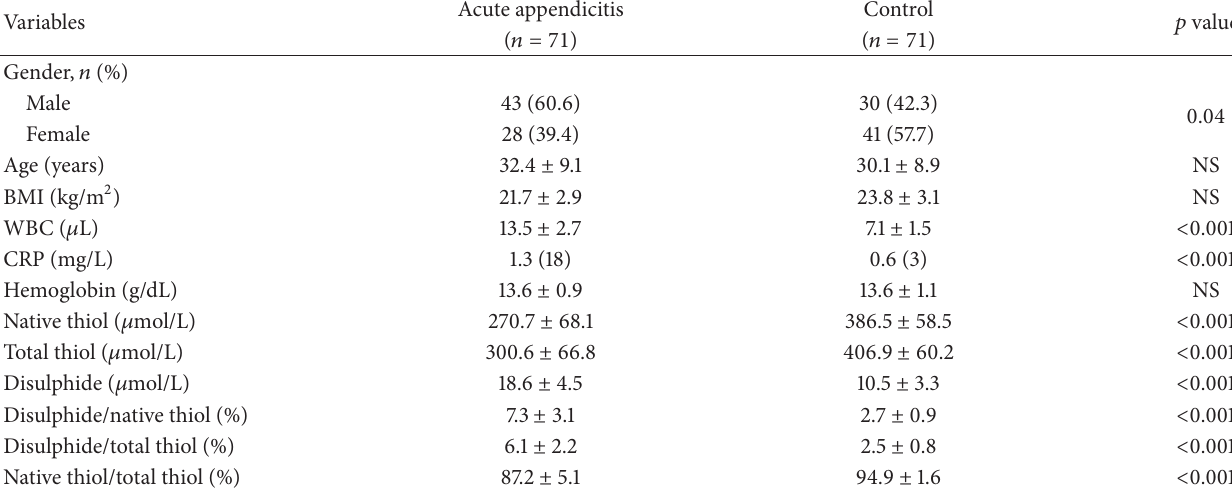
Table 1: The demographics and laboratory findings of AA and control groups.